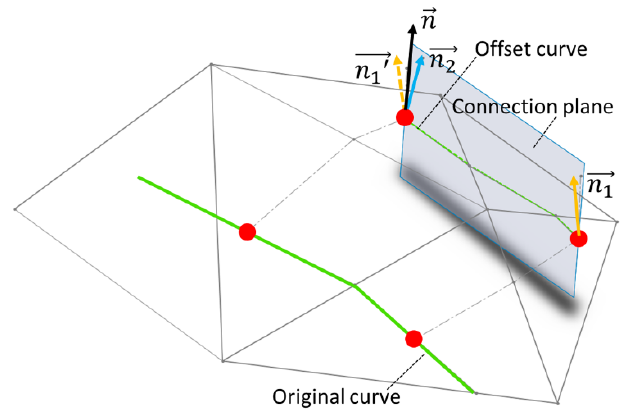
Figure 11. O ff set curve generation between two adjacent o ff set Figure 11. Offset curve generation between two adjacent offset points.